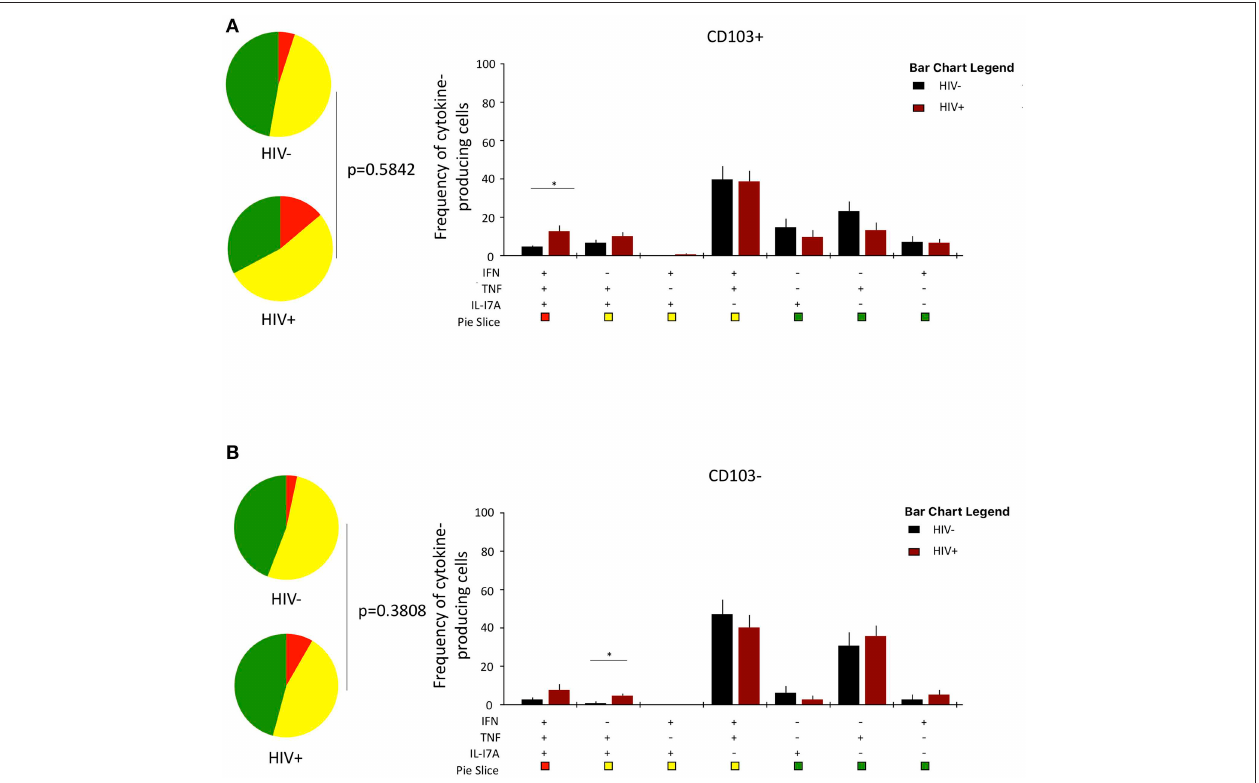
FIGURE 6 | Function profile of CD8 + CD161 ++ TCRv α 7.2 + T cells in healthy HIV-uninfected individuals compared to HIV-infected adults. BAL cells were stimulated with PMA/Ionomycin for 6h and responses were measured by intracellular cytokine staining for IL-17A, IFN- γ , and TNF. The phenotype of the responding cells was obtained by gating on singlets, lymphocytes, viable (LIVE/ DEAD Aqua), CD3 + cells, CD8 + cells, IL-17A + , and then a combination of CD161 and CD103. (A) CD103 + and (B) CD103 − . Each pie chart (top) represents the mean distribution across subjects of mono-functional, bi-functional and poly-functional cytokine producing cells (color coded as shown) within the total response in a particular CD8 + CD161 ++ TCRv α 7.2 + T cell subset. Bar charts (bottom) represent the mean and standard error of the mean (SEM) of the contribution of the indicated subset (x-axis) toward the total response against the indicated CD8 + CD161 ++ TCRv α 7.2 + T cell subsets (color coded as shown) ( n = 11). Permutation test was performed among the pie charts and Wilcoxon test was done among the bar charts using SPICE software (* p < 0.05). BAL, bronchoalveolar; IFN, interferon-gamma; TNF, tumor necrosis factor; IL17,